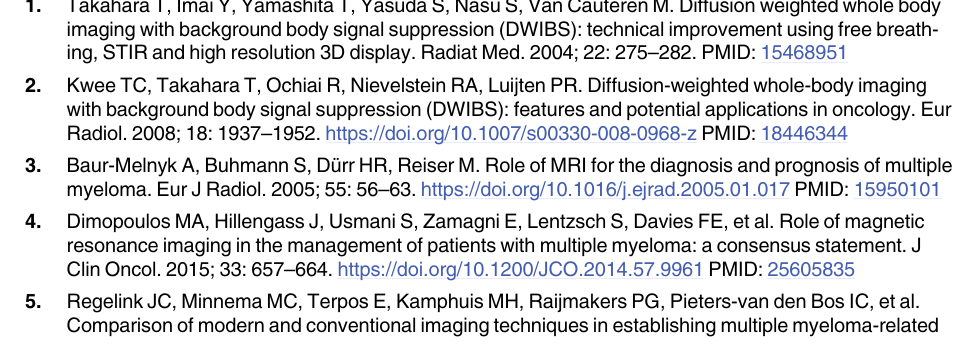
. Δ ADC for mean mean